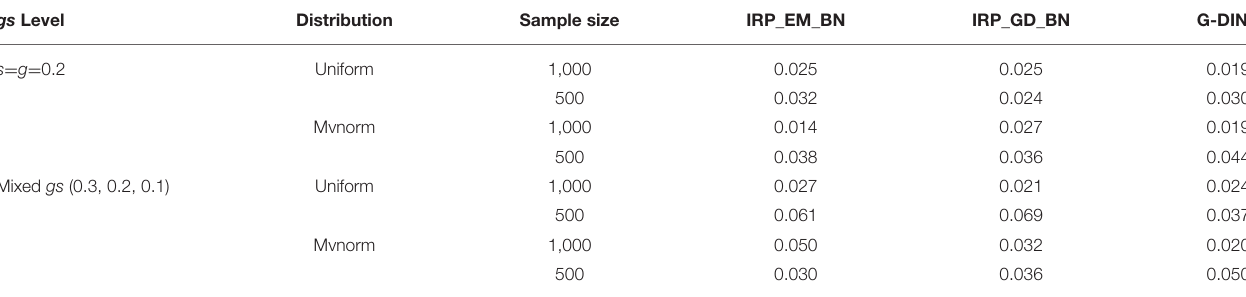
TABLE 6 | The standard error of PCR by BNs and G-DINA from the data generated by G-DINA. gs Level Distribution Sample size IRP_EM_BN IRP_GD_BN G-DINA s = g = 0.2 Uniform